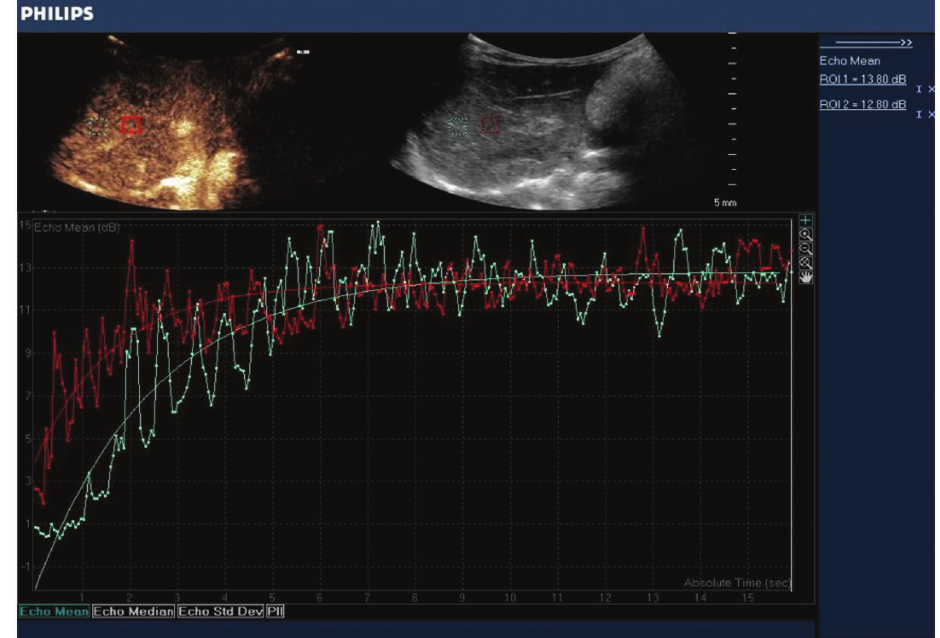
Figure 4. Hepatic perfusion time-intensity curves at different regions of interest positions at a depth of 3 cm from the liver capsule. The green square and the green curve denote position a. The red square and the red curve denote position b. The two positions were not signi fi cantly different in peak intensity (P=0.266, t -test).